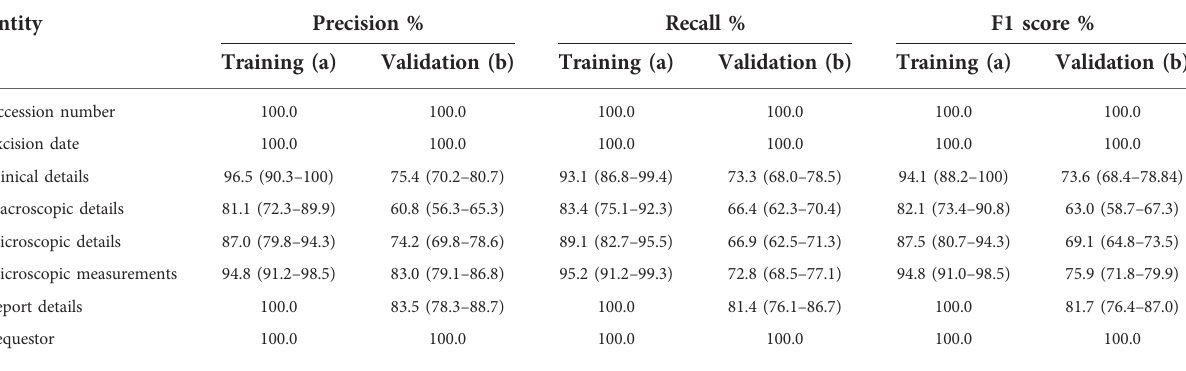
TABLE 3 Performance of the natural language processing pipeline on (a) training and (b) corpus compared to clinician assessment. Values calculated per document across annotation types and averaged across the corpus, displayed with 95% con fi dence intervals.